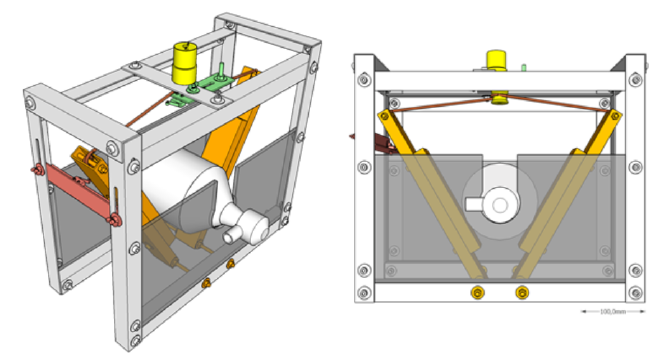
Figure 15. Three-dimensional render of the eARM prototype diagonally and from the front. Yellow: Motor with string roll, Orange: Squeezing arms, Green: Upper endswitch (volume and pressure control), Red: Lower endswitch (Timing control). The design will require